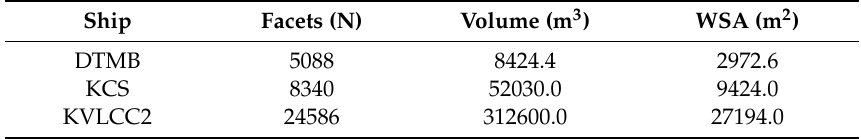
Table 2. The published value of DTMB5415, KCS and KVLCC2. WSA: wetted surface area.